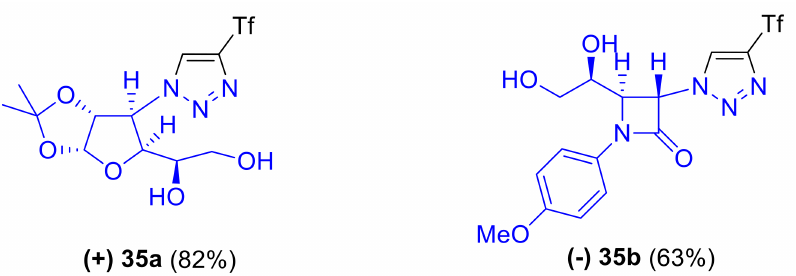
Figure 3. 1,4-DTs obtained by Alcaide et al. maintaining the stereochemical integrity of the enantiop- ure